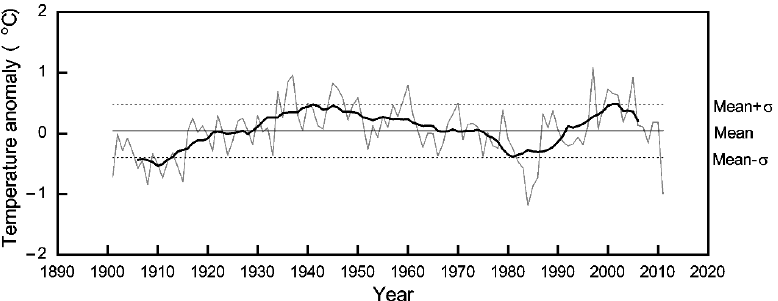
Figure 5. Reconstructed T DS from 1901 to 2011 for the Ejina region (the bold line represents the 11-year moving average data).